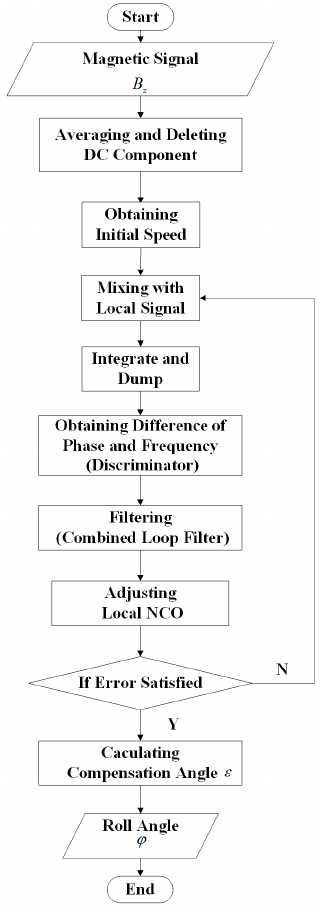
Figure 4. Process of obtaining roll angle.